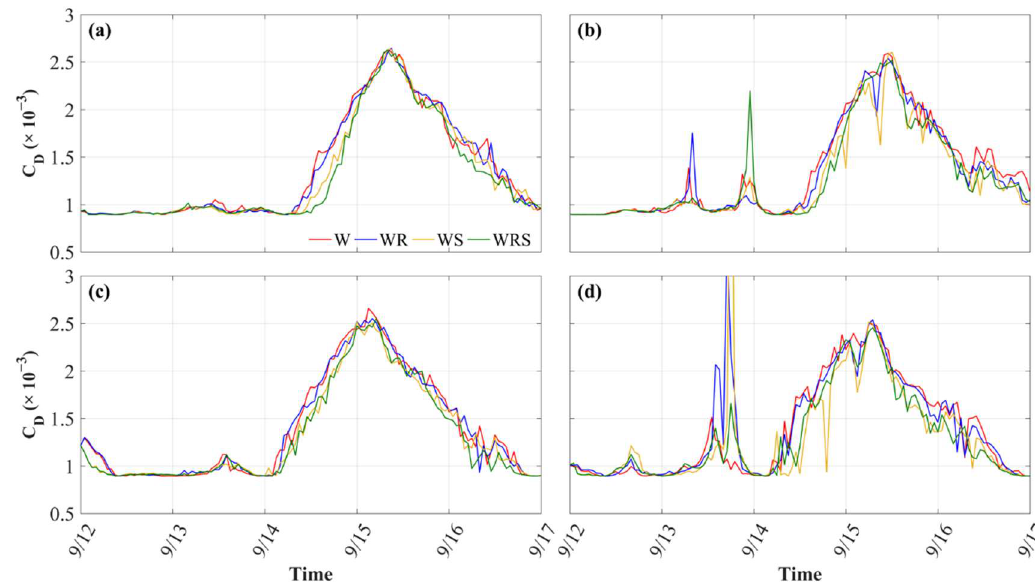
Figure 9. Comparison of C D s derived from simulated 10-m wind speed (m s − 1 ). ( a ) Buoy 1; ( b ) Buoy 2; ( c ) Buoy 4; and ( d ) Buoy 5. W (red), WR (blue), WS (orange) and WRS (green).